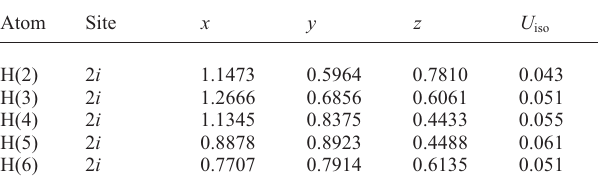
Table 2. Atomic coordinates and displacement parameters (in Å 2 ) .